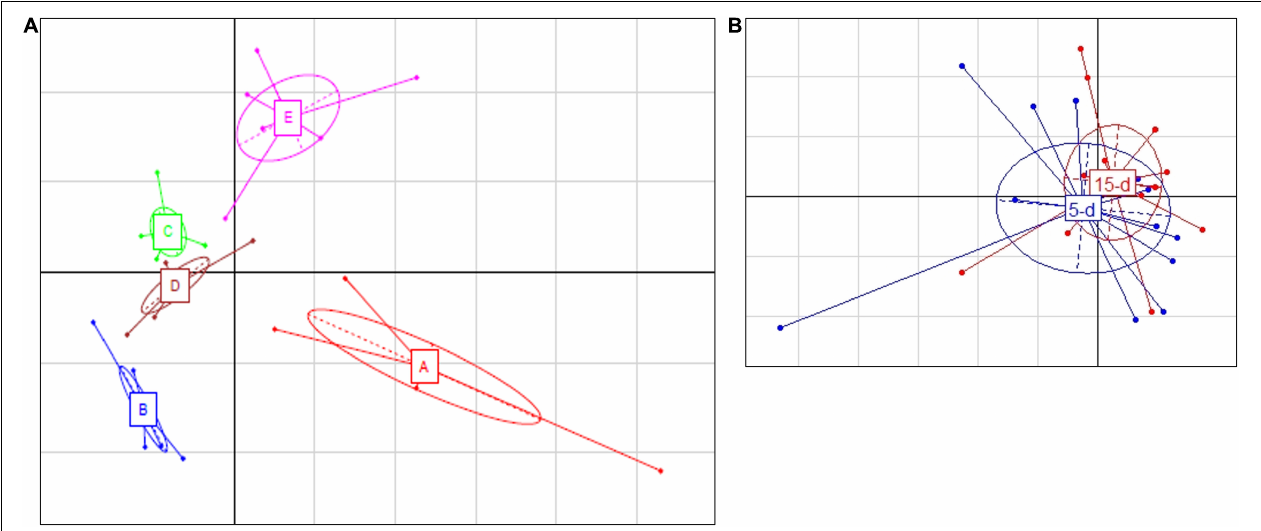
FIGURE 4 | Principal Component Analysis based on ASV relative abundance of fungal microbiota targeted by 26S rRNA gene. (A) Differences among different dairy plants; the first component (horizontal) accounts for the 28.16% of the variance, and the second component (vertical) accounts for the 21.85%. The five different dairy plants are indicated as follows: A (red bars), B (blue bars), C (green bars), D (brown bars), and E (magenta bars). (B) Differences between 5-day (blue) and 15-day ripened cheese (red) analyzed. The first component (horizontal) accounts for the 20.20% of the variance, and the second component (vertical) accounts for the 15.03%. Ellipses in the graph are drown around similar cluster. The bars which originated from a common centroid highlighted the difference between samples belonging to the same